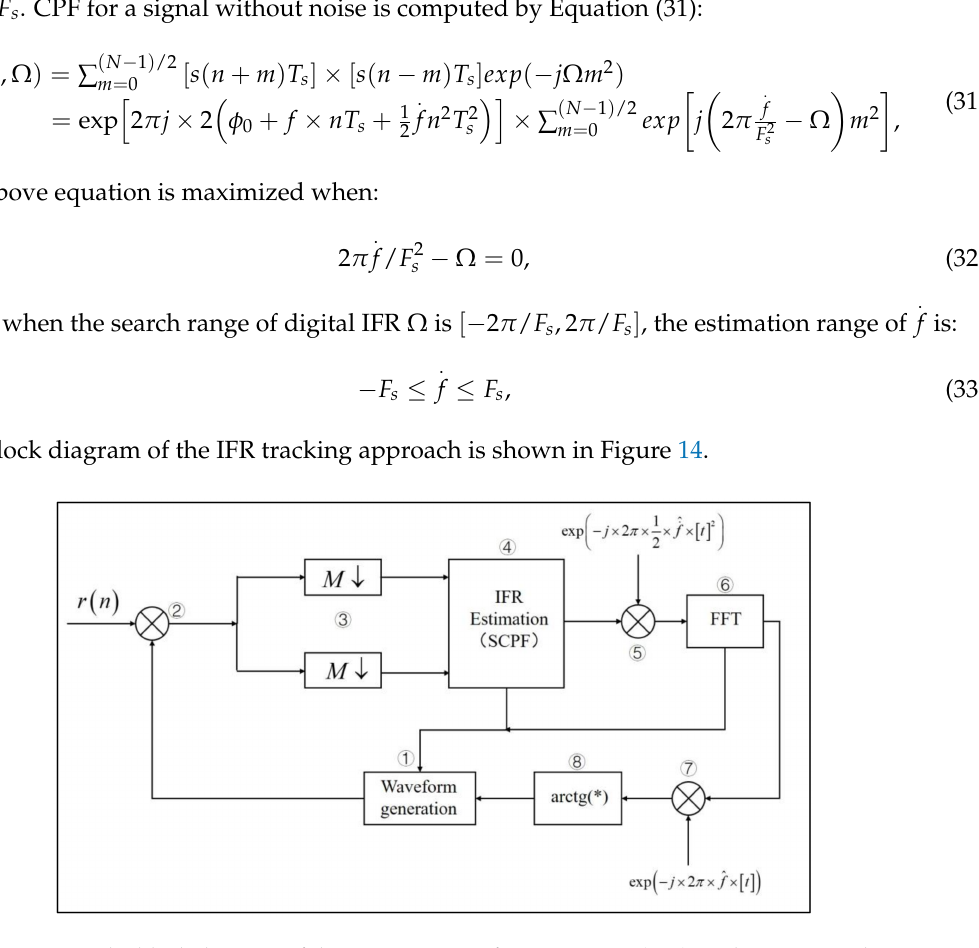
Figure 14. The block diagram of the instantaneous frequency rate (IFR) tracking